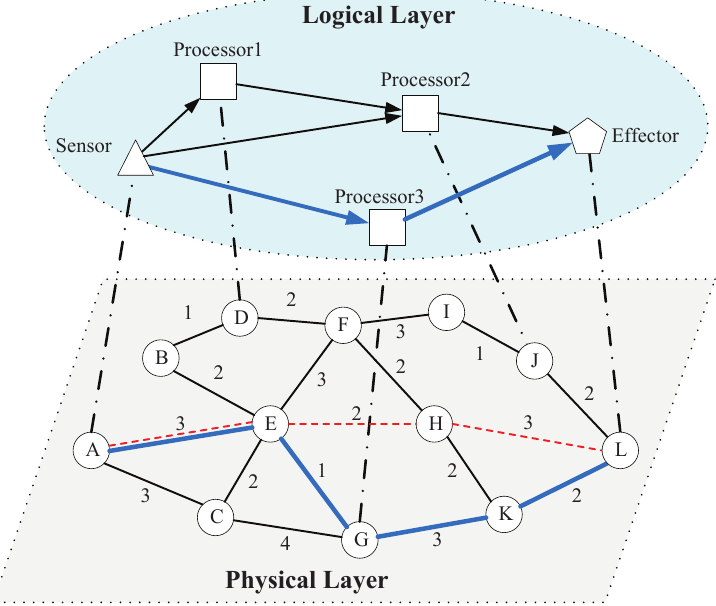
Figure 1. A simple example of the logical–physical network in IoT. The logical layer contains a sensor, an effector and three different processors. The physical layer is the communication network, where the time delay of each link is given by the number beside it. Each dotted line between the two layers connects the functional part and the communicating part of the same entity. The sensor collects information and sends it to either of the processors. The processor analyzes the information and then sends order to the effector. As the figure shows, the shortest logical flow Sensor → Processor3 → Effector corresponds to a physical path A(Sensor) → E → G(Processor 3) → K → L(Effector) , which weighs 9. Although the shortest A – L path on the physical layer is A(Sensor) → E → H → L(Effector) with total weight 8, it is not functionally feasible because no processor is on this path and thus no effective order can be sent to